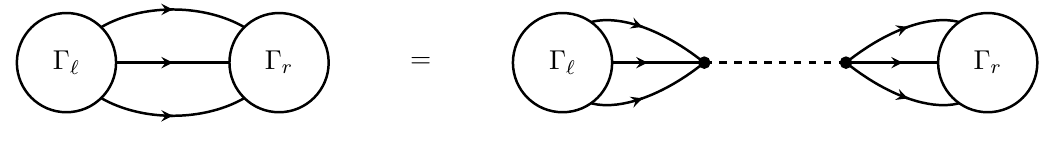
Figure 30 . A crucial identity for spherical fusion category evaluation maps: a graph (cid:0) (Left) can be split into two simpler graphs (cid:0) 1 and (cid:0) 2 (Right) with a sum over a complete set of dual local operators at the new junctions (dashed